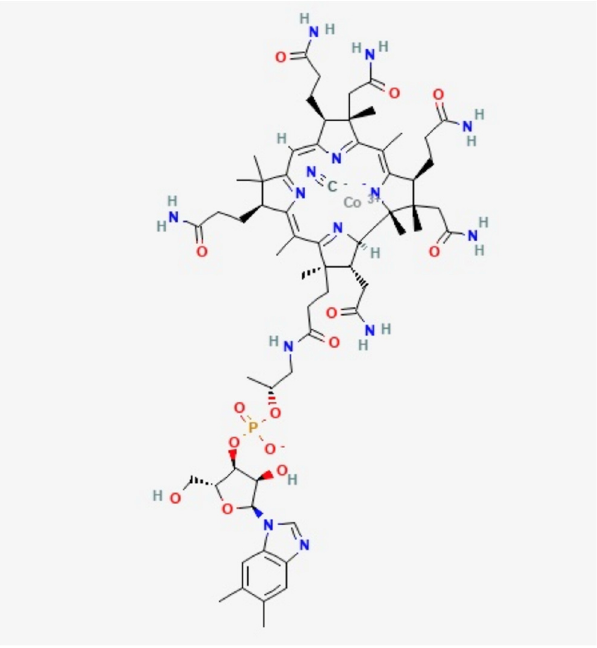
Figure 1. Vitamin B12 chemical structure